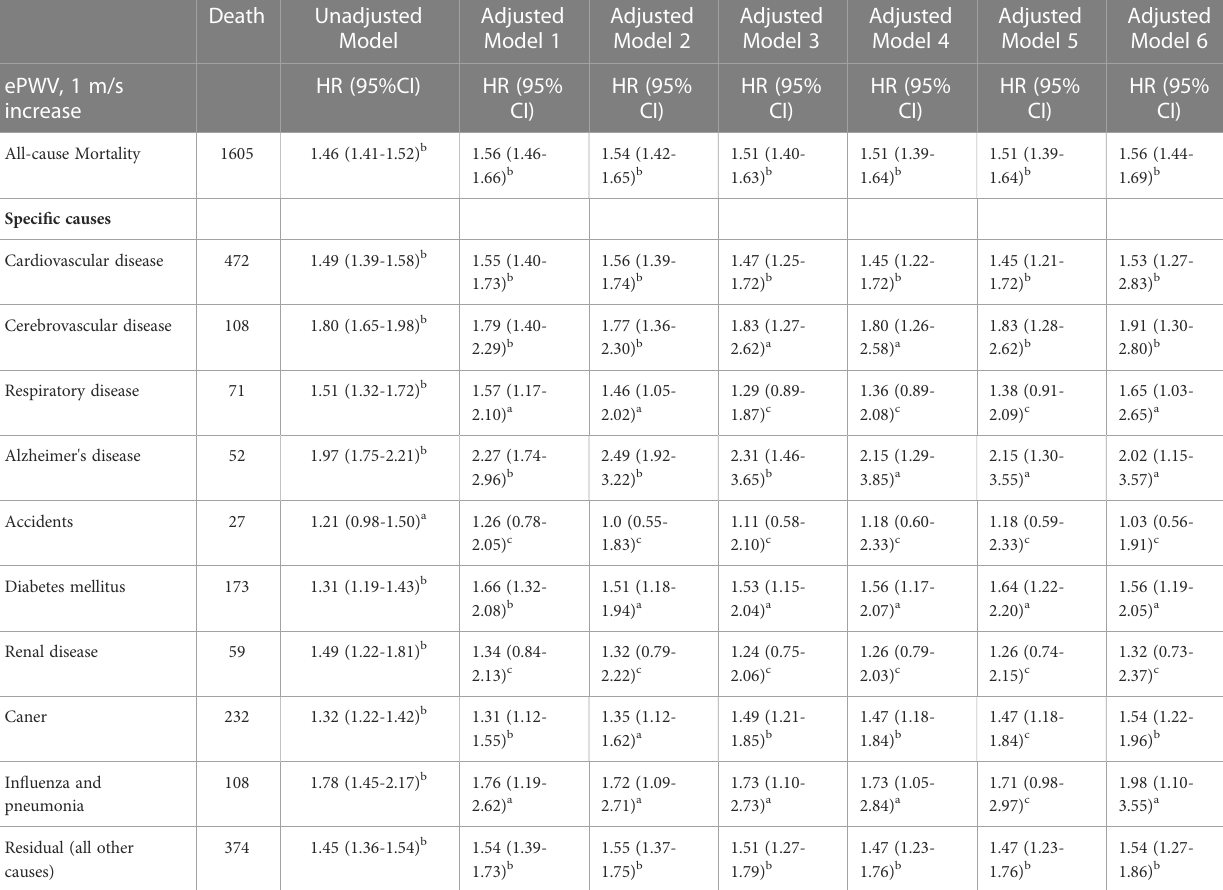
TABLE 2 Survey-Weighted Cox Proportional Hazard Results Examining the Association of ePWV on All-Cause and Cause-Speci fi c Mortality in diabetes population from NHANES 1999 to 2014.